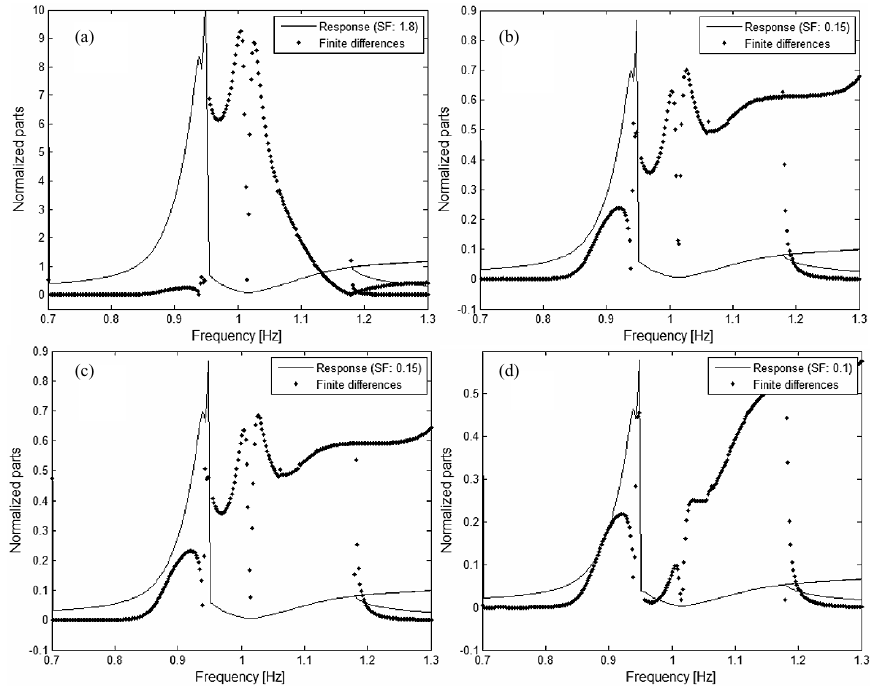
Fig. 3. Finite difference estimations of the Response H ( ω,p ) with respect to ε 2 : (a) ∆ ε 2 / ε 2 = 1%; (b) ∆ ε 2 / ε 2 = 5%; (c) ∆ ε 2 / ε 2 = 10%; (d) ∆ ε 2 / ε 2 =